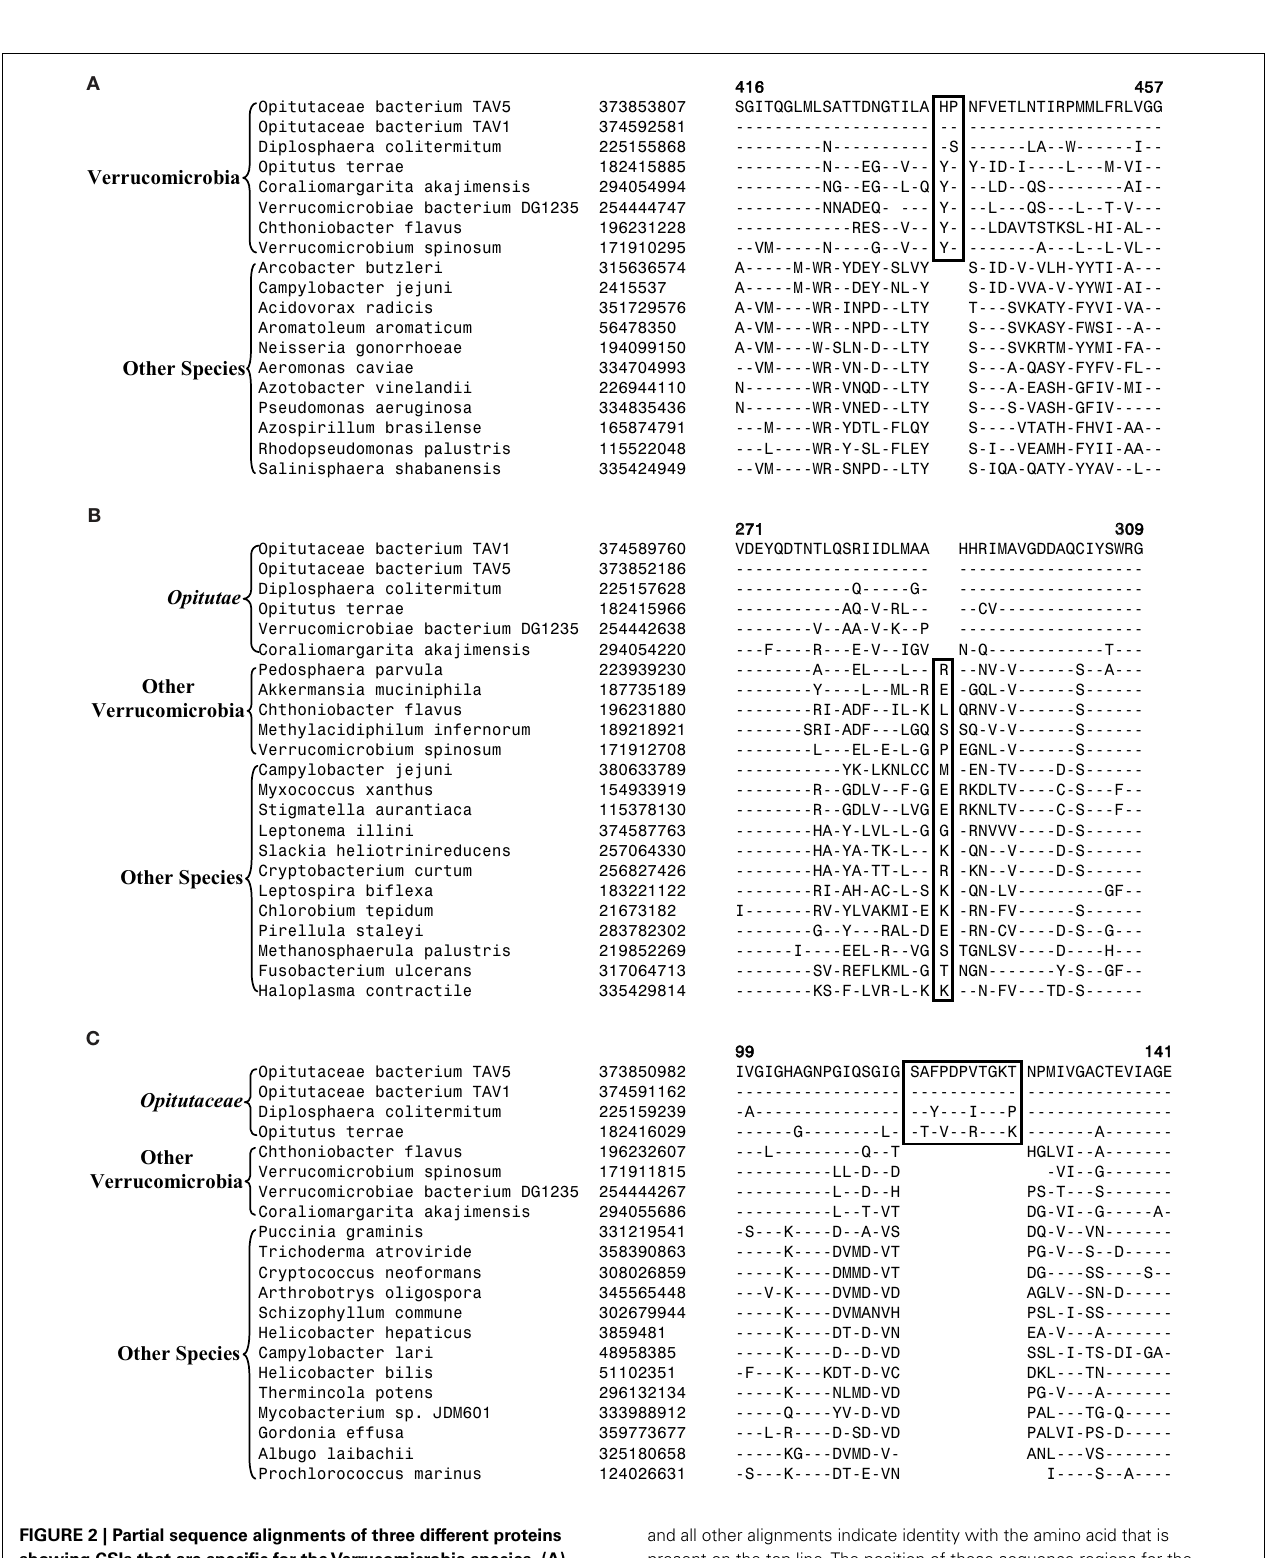
FIGURE 2 | Partial sequence alignments of three different proteins showing CSIs that are specific for theVerrucomicrobia species. (A) A 2 aa CSI in a conserved region of Cytochrome c oxidase (cbb3-type) subunit 1 that is specific for all sequencedVerrucomicrobia species where homologs of this protein were identified; (B) A CSI consisting of 1 aa deletion in the UvrD helicase that is specific for the Opitutae class; and (C) An 11 aa insert in the Urease alpha subunit that is specific for the Opitutaceae family.The CSIs are boxed and the dashes (–) in this